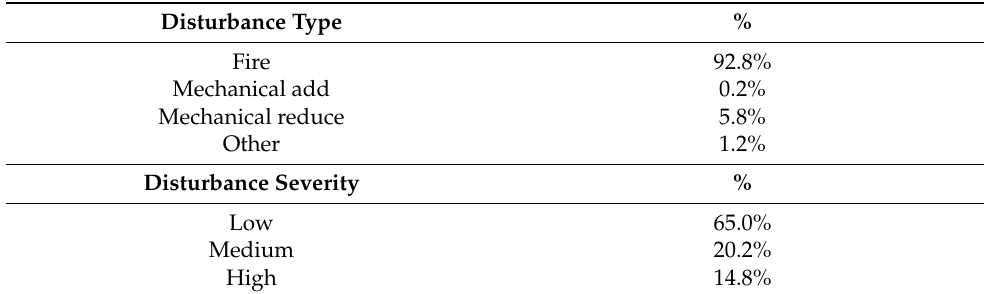
Table 1. Distribution of disturbance types and